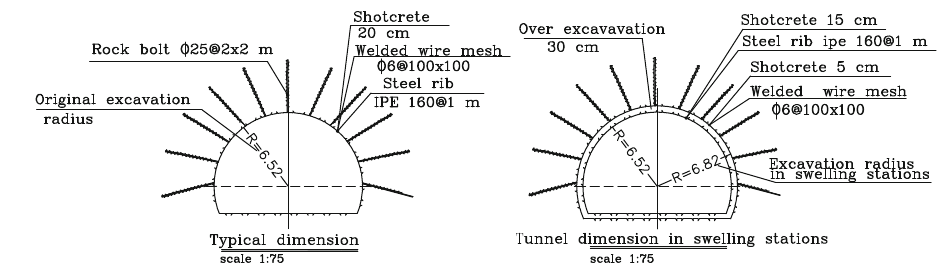
Fig. 11 Over excavation technique in swelling stations